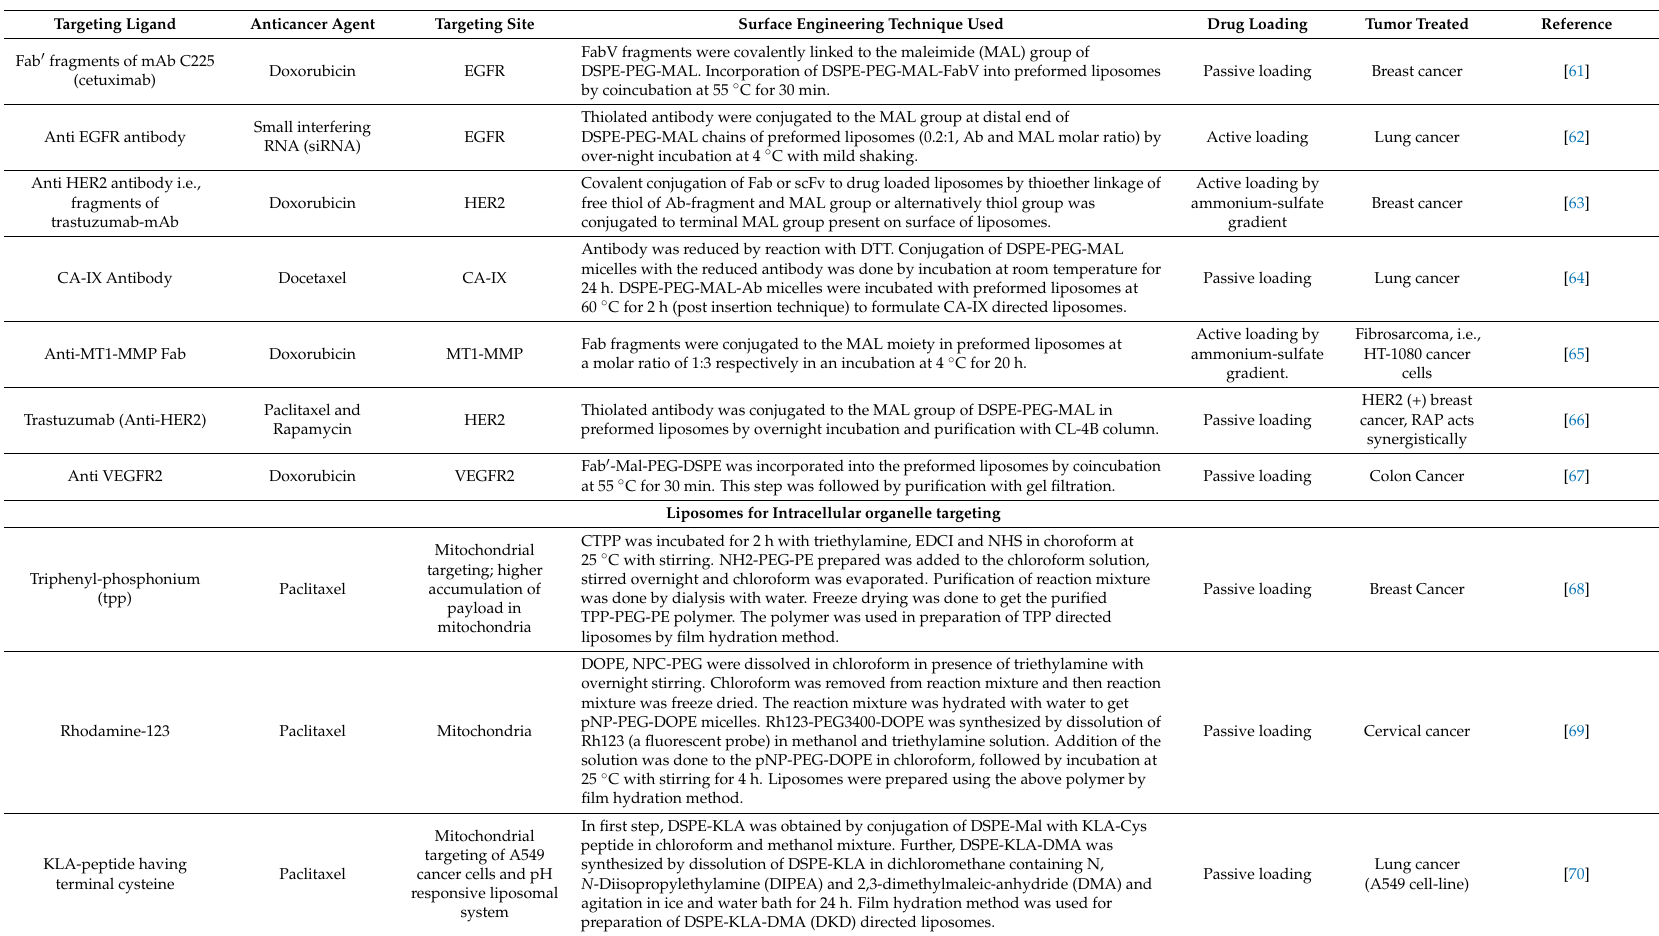
Table 1. Surface engineered liposomes functionalized with targeting ligands for solid tumor